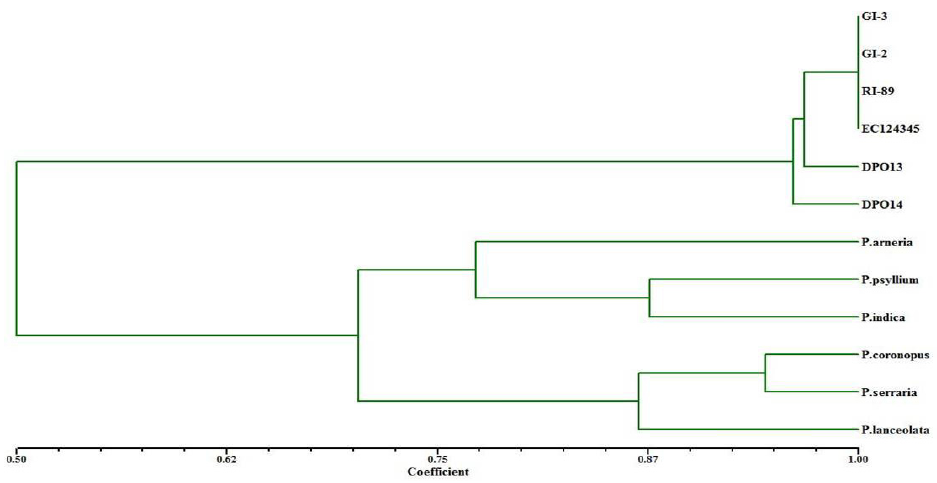
Figure 3. Dendrogram based on UPGMA clustering of 12 genotypes of isabgol using SSR